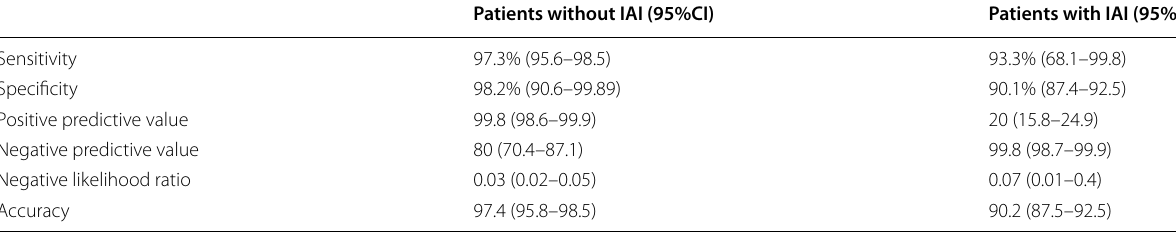
IAI intraabdominal injury Table 3 The hospital cost of each patients Outcome Total cost (TL) Patient with IAI, abnormal CT, and admitted to